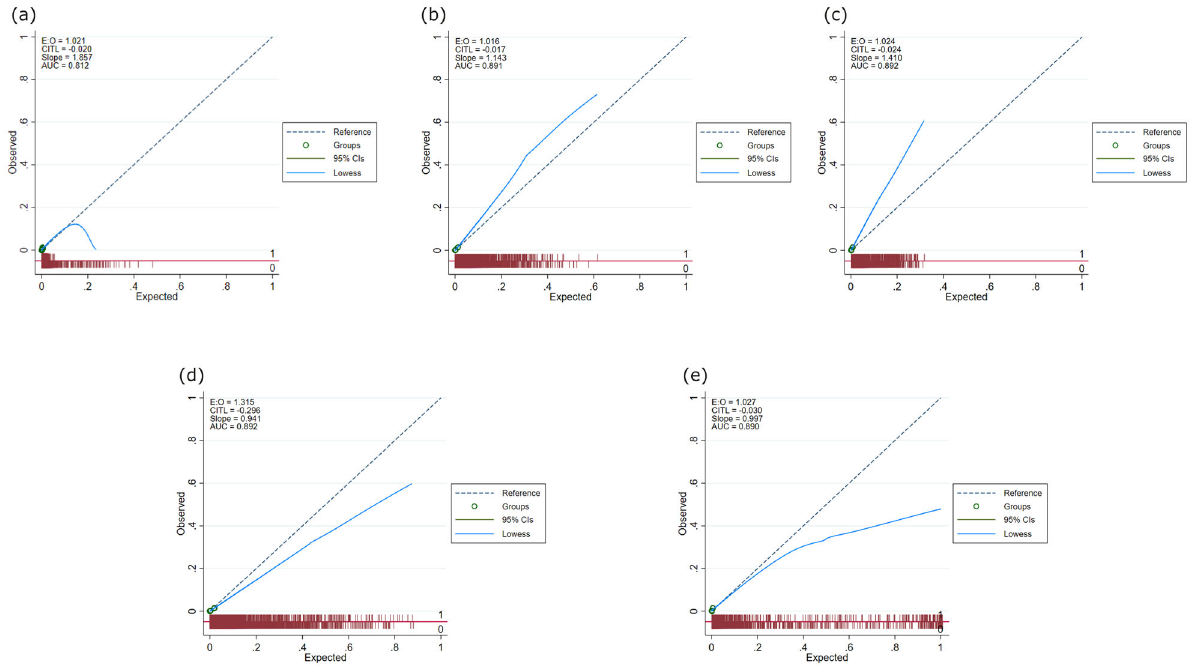
Fig. 4 Calibration plots for all models. Based on validation cohort of 1,006,943 patients: a logistic regression model, b random forest model, c gradient boosting model, d deep-learning model and e ensemble model. E:O log of the expected/observed number of events, CITL calibration-in-the-large, AUC area under the curve, slope calibration slope. The circles represent deciles of patients grouped by similar predicted risk. The distribution of patients (strati fi ed by outcome) is indicated with spikes at the bottom of the graph. Patients with a diagnosis of familial hypercholesterolaemia (FH) are represented by spikes above the x -axis (red line), and patients without a diagnosis of FH, below the x -axis).